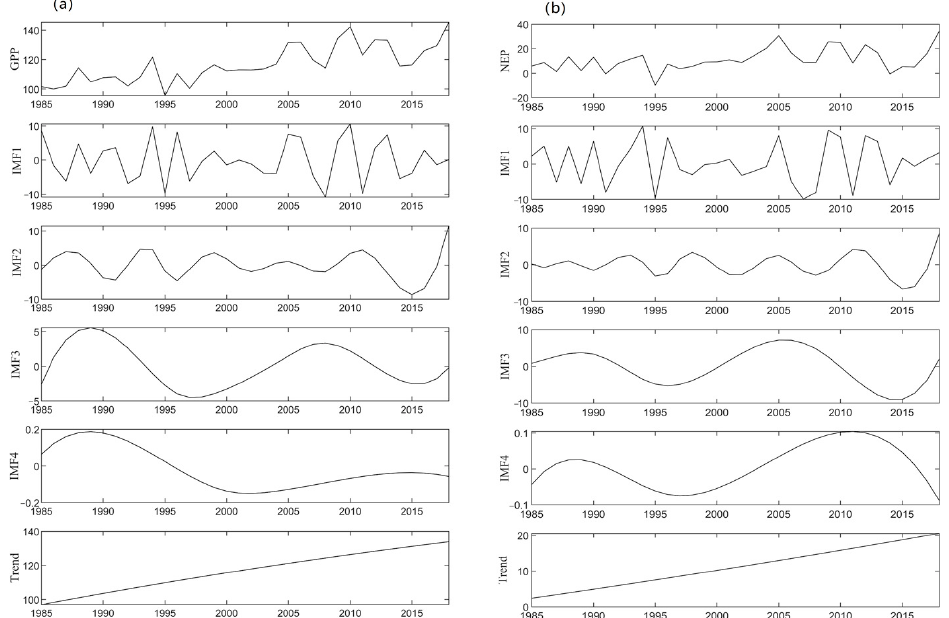
Figure 2. Correlation analysis between two GPPs products in the TRSR.